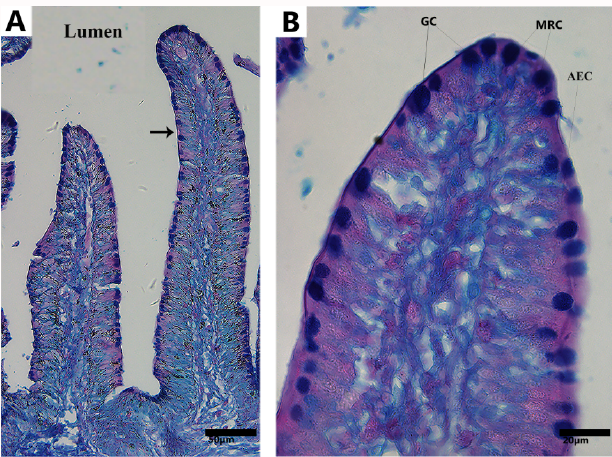
Figure 1. Light microscopy of the small intestine of Pelodiscus sinensis . Three main types of epithelial cells were present in the mucosal surface of the small intestine: mitochondria-rich cells (MRCs), absorptive epithelial cells (AECs), goblet cells (GCs), and villus (black arrow). Scale bars = ( A ) 50 µm and ( B ) 20 µm.